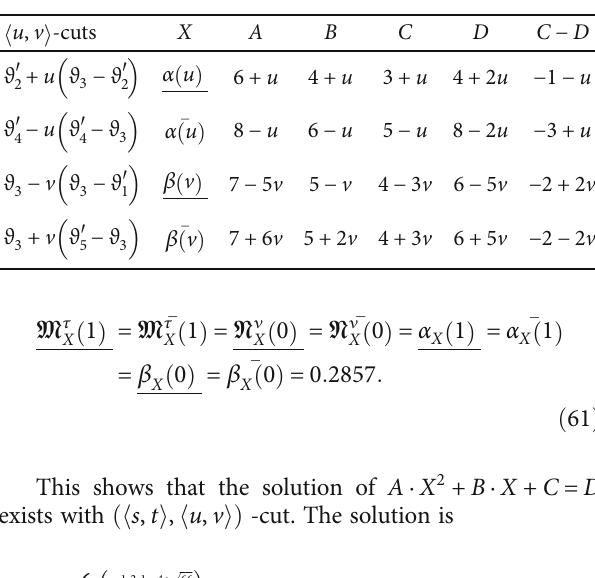
Figure 6: Solution by h s , t i -cut. Table 2: h u , v i -cuts of A , B , C , D , and X